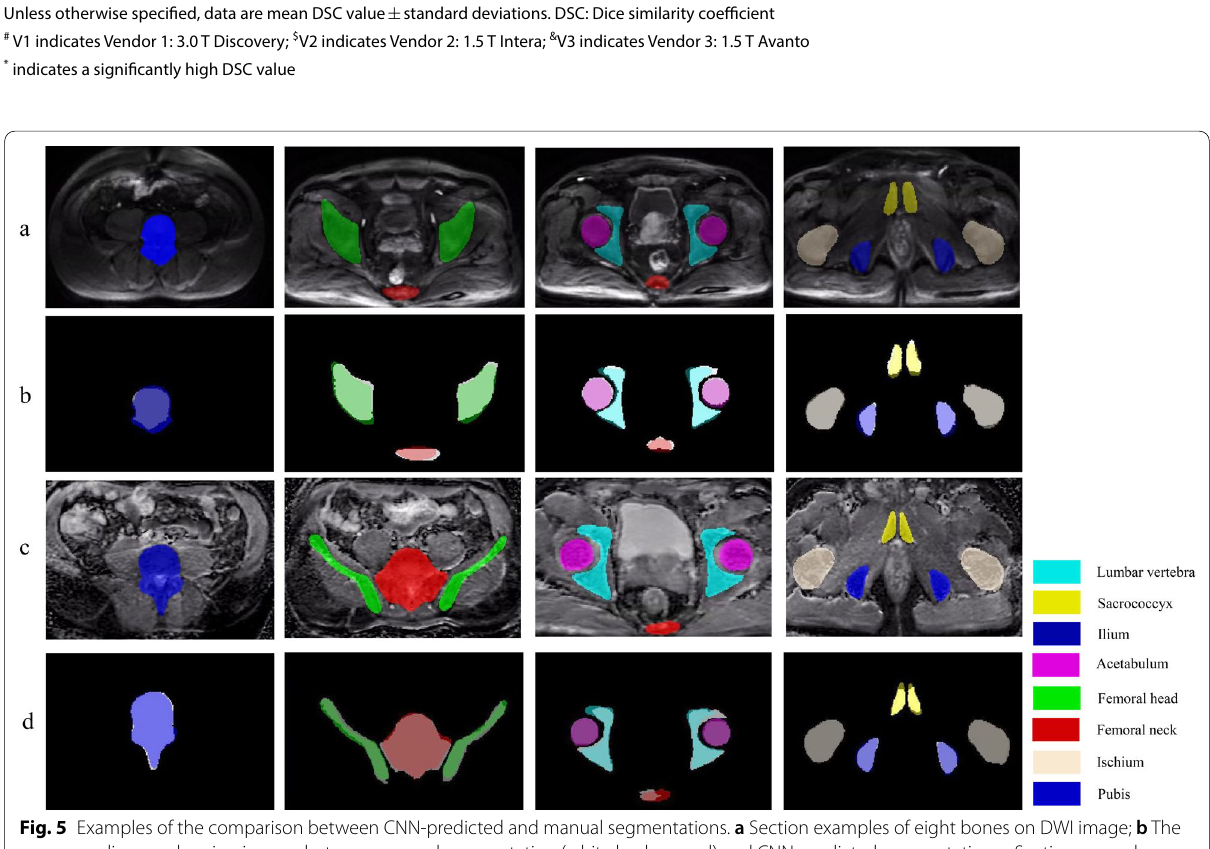
standard deviations. DSC: Dice similarity coefficient ±